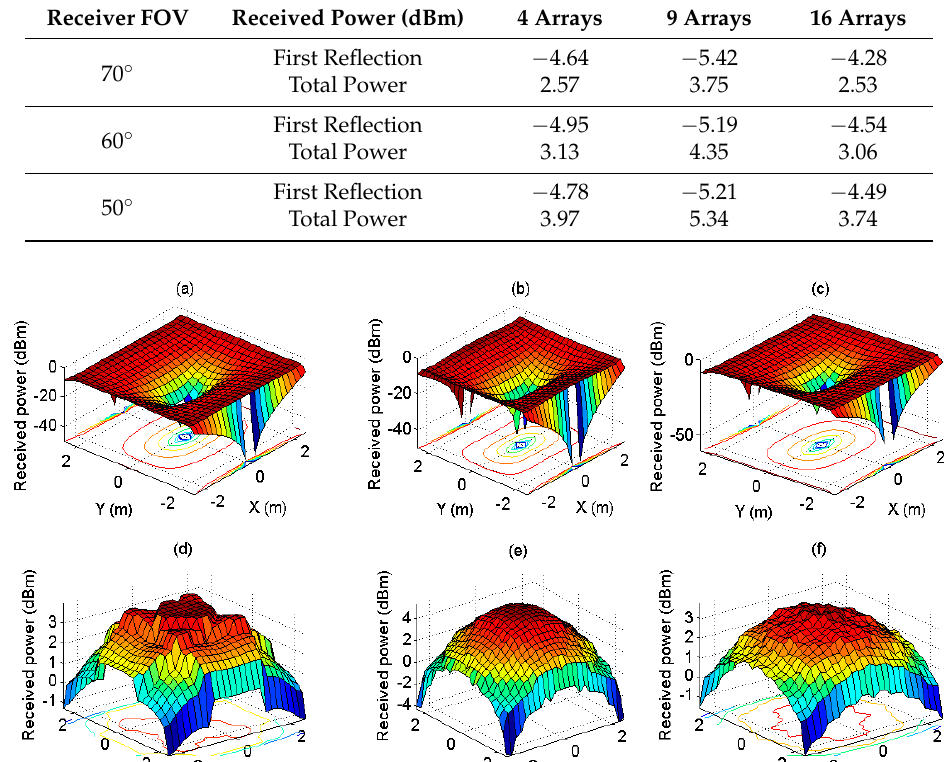
Table 3. Maximum power received after changing the FOV.